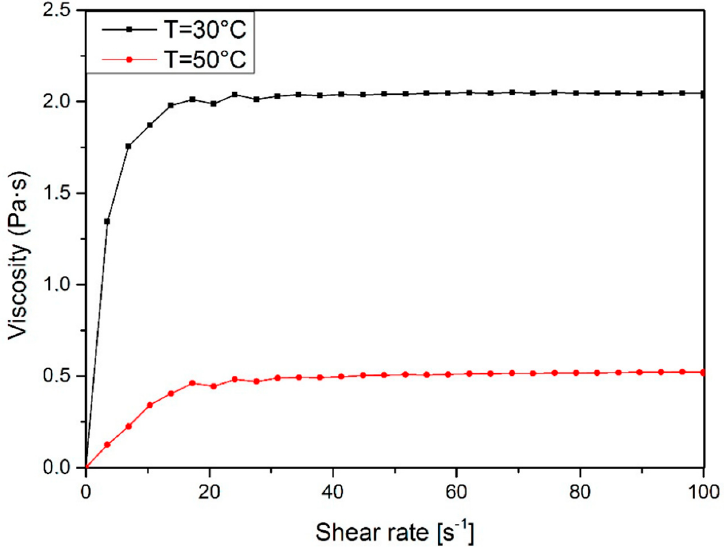
Figure 5. The viscosity curves of obtained polyol at different temperatures.